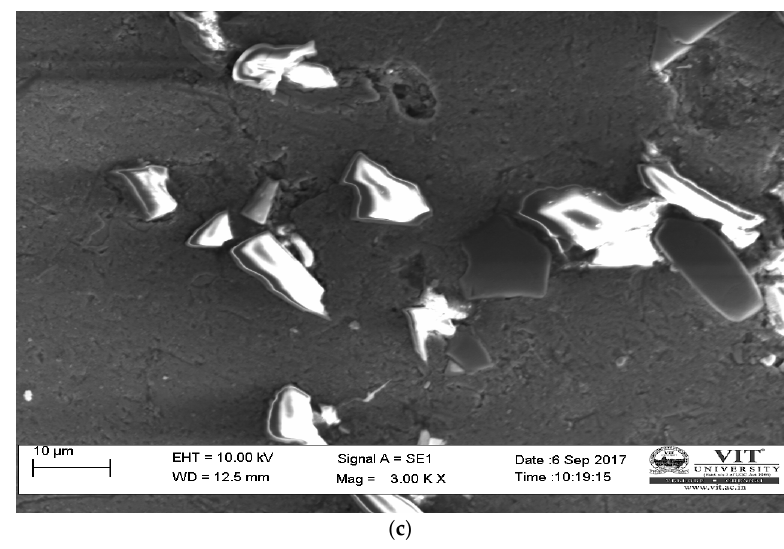
Figure 1. ( a ) Optical image AA6061/ZrO 2 -5% composite, ( b ) scanning electron microscope (SEM) image of AA6061/ZrO 2 -15% composite, ( c ) SEM image of AA6061/ZrO 2 -10% composite. Table 2. Weight of elements of AA6061/ZrO 2 .